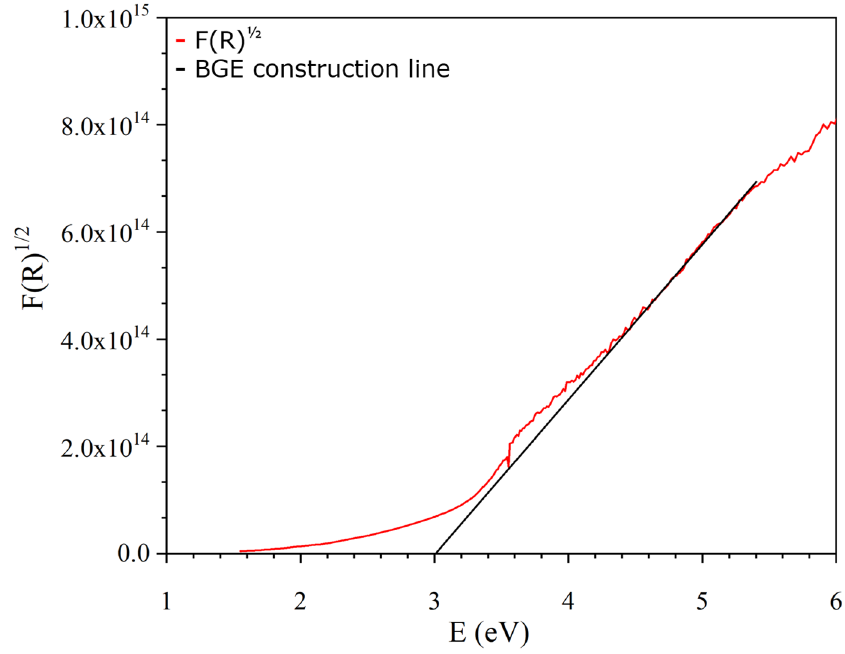
Figure 3. Tauc plot for POF/TiO 2